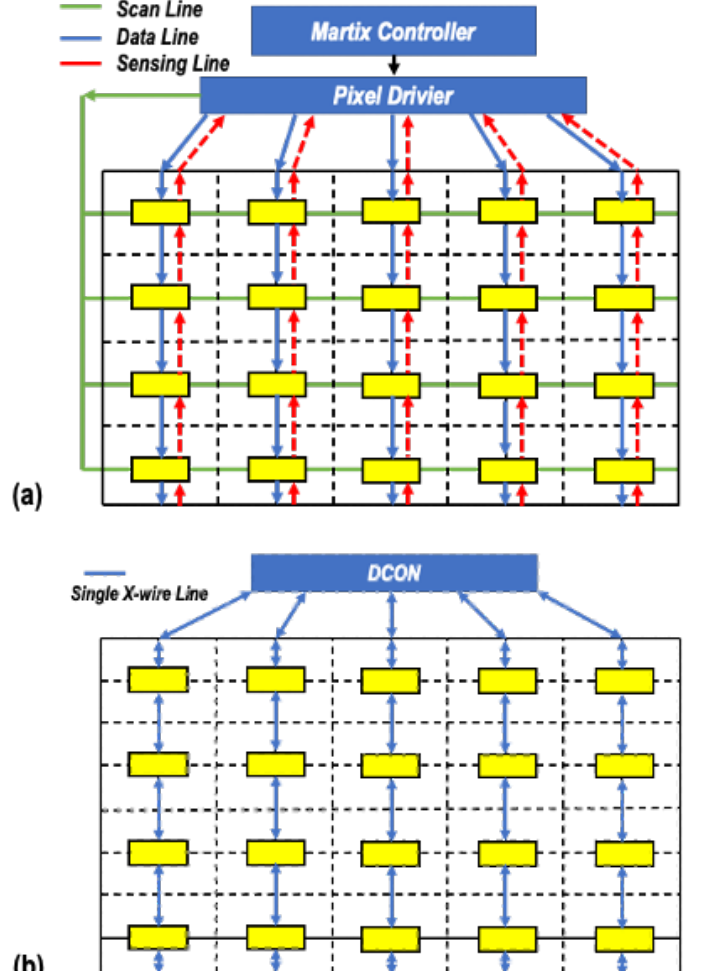
Figure 1. ( a ) Conventional AM mini-LED backlight system and ( b ) proposed new single X-wire AM mini-LED backlight system.